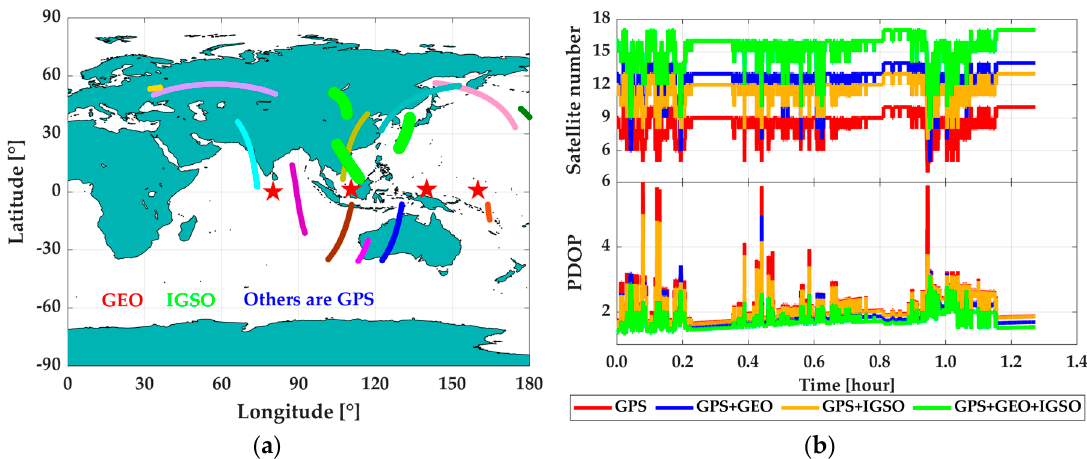
Figure 5 . Satellite sky plot ( a ) and the corresponding position dilution of precision (PDOP) ( b ) during the land-borne test.